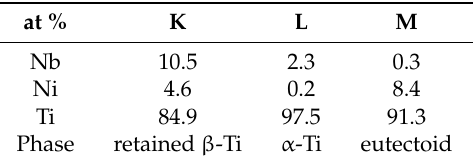
Figure 6. EPMA BEIs of CP-Ti/40Ti-35Ni-25Nb/CP-Ti joint brazed at 1200 °C for 600 s: ( a ) cross section overview, ( b ) higher magnification of location V in ( a ), ( c ) higher magnification of location VI in ( a ). Table 3. EPMA quantitative chemical analysis results in Figure 6.